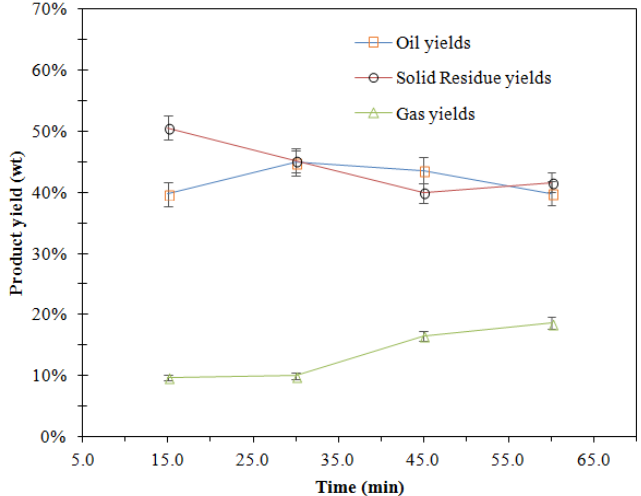
Figure 5. Effects of holding time on products yield (H2O-EtOH medium, 250 °C, H 2 SO 4 catalyst, heating time for 0.5 h).